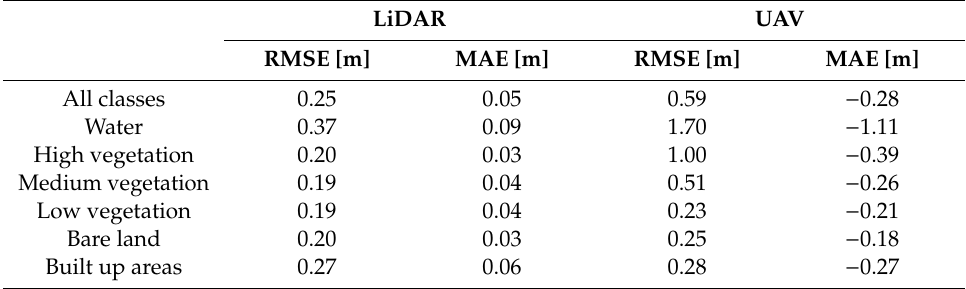
Table 5. Accuracy of LiDAR and UAV digital elevation model (DEM) per land cover / land use classes (root mean square error (RMSE) and mean average error (MAE)) using the DEM of di ff erence (DoD) method. LiDAR